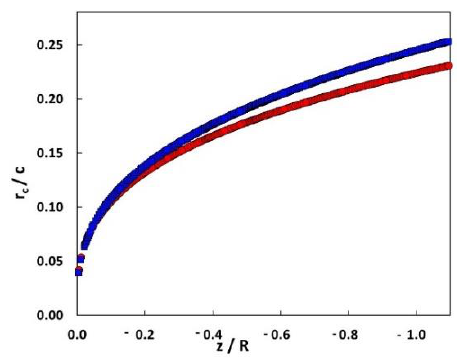
14 of 20 Figure 11. Normalized tangential velocity and circulation vs. r/c for each detected vortex. The results have shown a decrement of the swirl velocity that follows a second-order trend as the distance from the rotor increases. The circulation decreases as the distance from the disk increases.